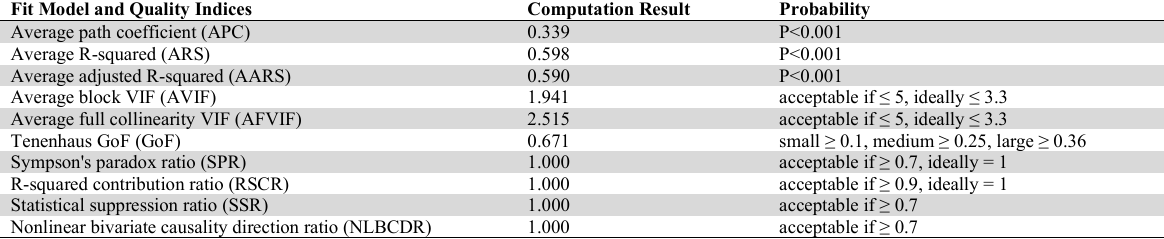
Goodness of Fit Test (Fit Model and Quality Indices) Fit Model and Quality Indices